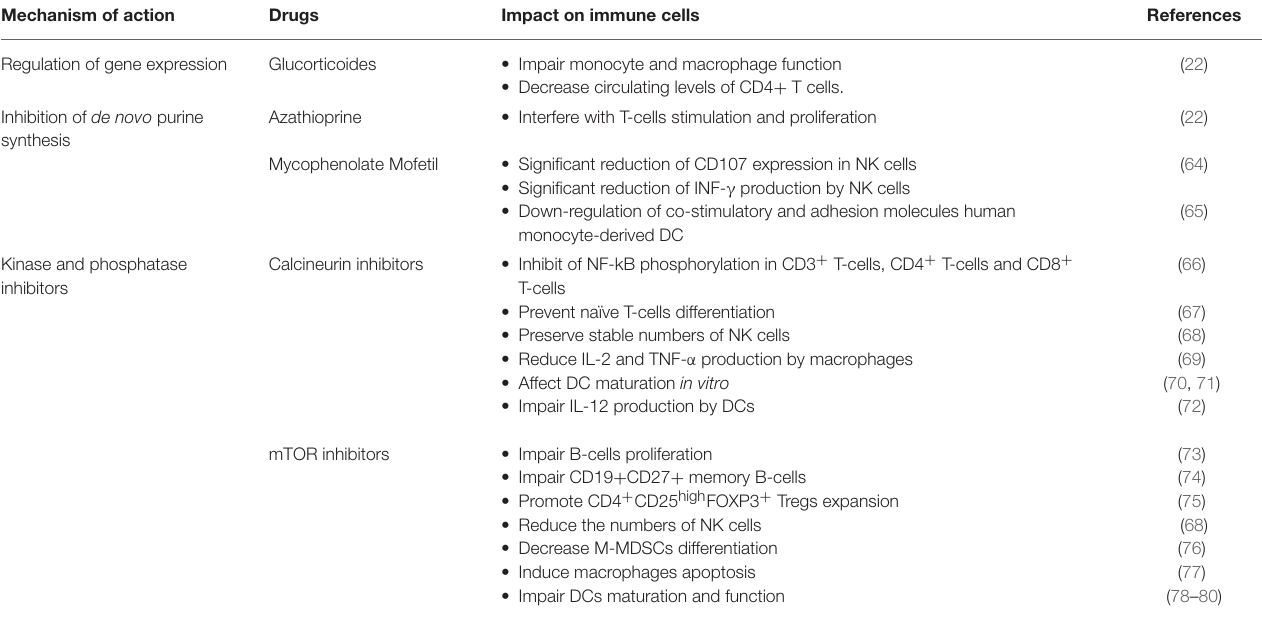
TABLE 1 | Main effects exerted by immunosuppressive drugs on immune